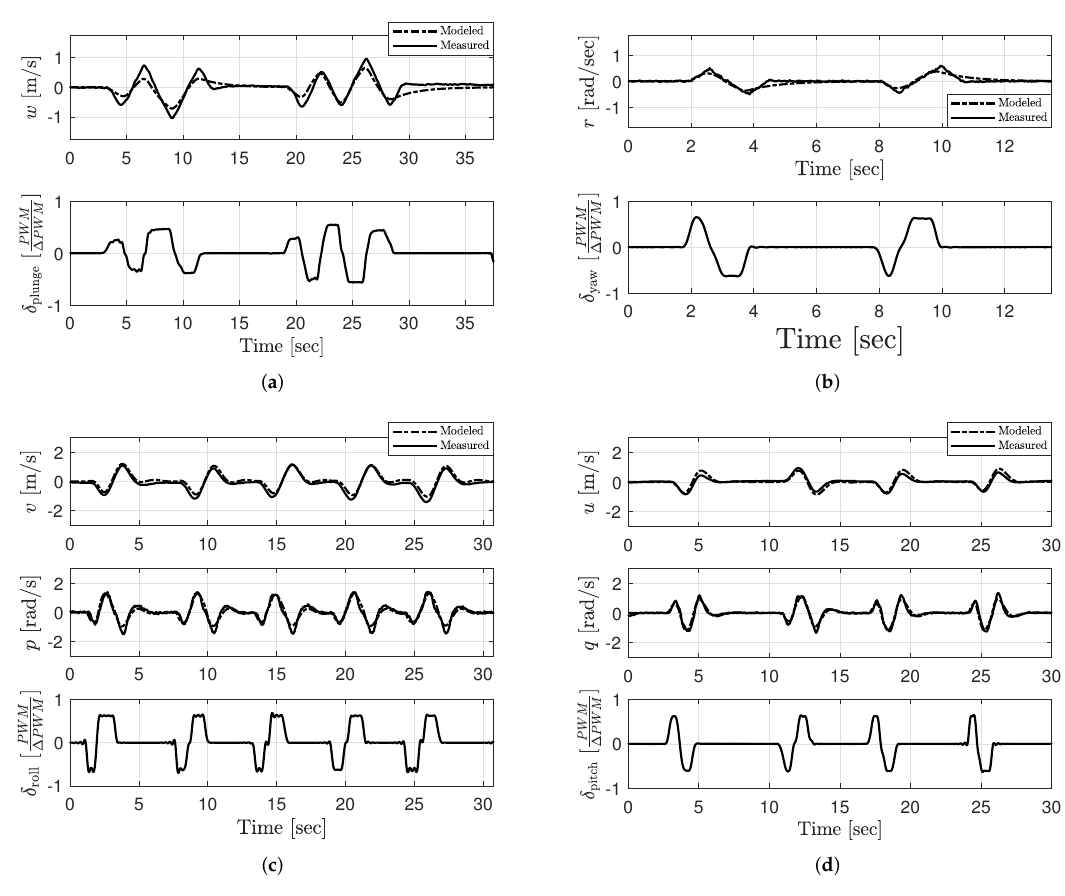
Figure 6. Validation of the ( a ) plunge, ( b ) yaw, ( c ) roll, and ( d ) pitch models identified for quadrotor hovering flight. Table 7. System identification validation results for plunge, yaw, roll and pitch